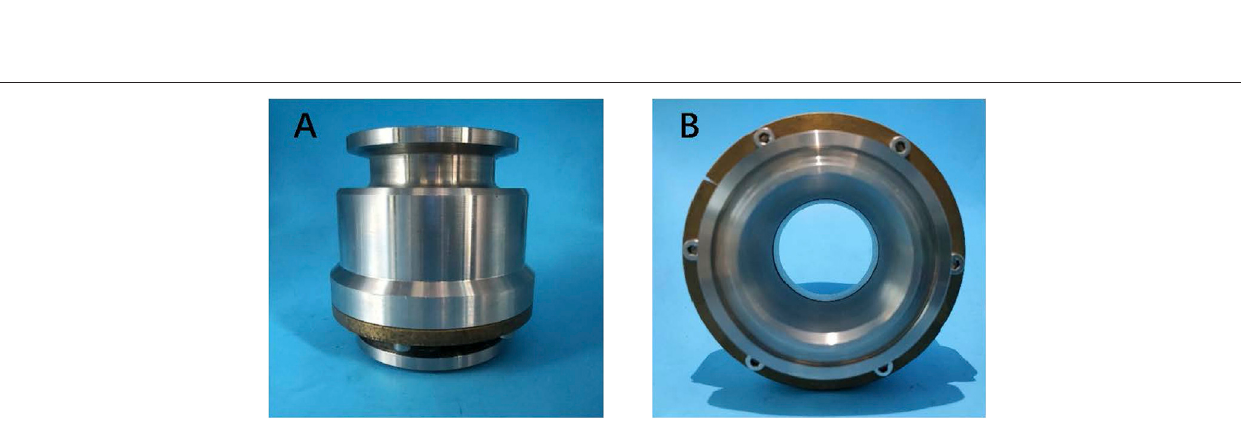
FIGURE7| Fieldstrength distributionontheinner ofthewaveguide. (A) Thesectionalviewof fi eldstrength distribution insidethewaveguide. (B) Position1viewof fi eld strength distribution inside the waveguide. (C) Position 2 view of fi eld strength distribution inside the waveguide.